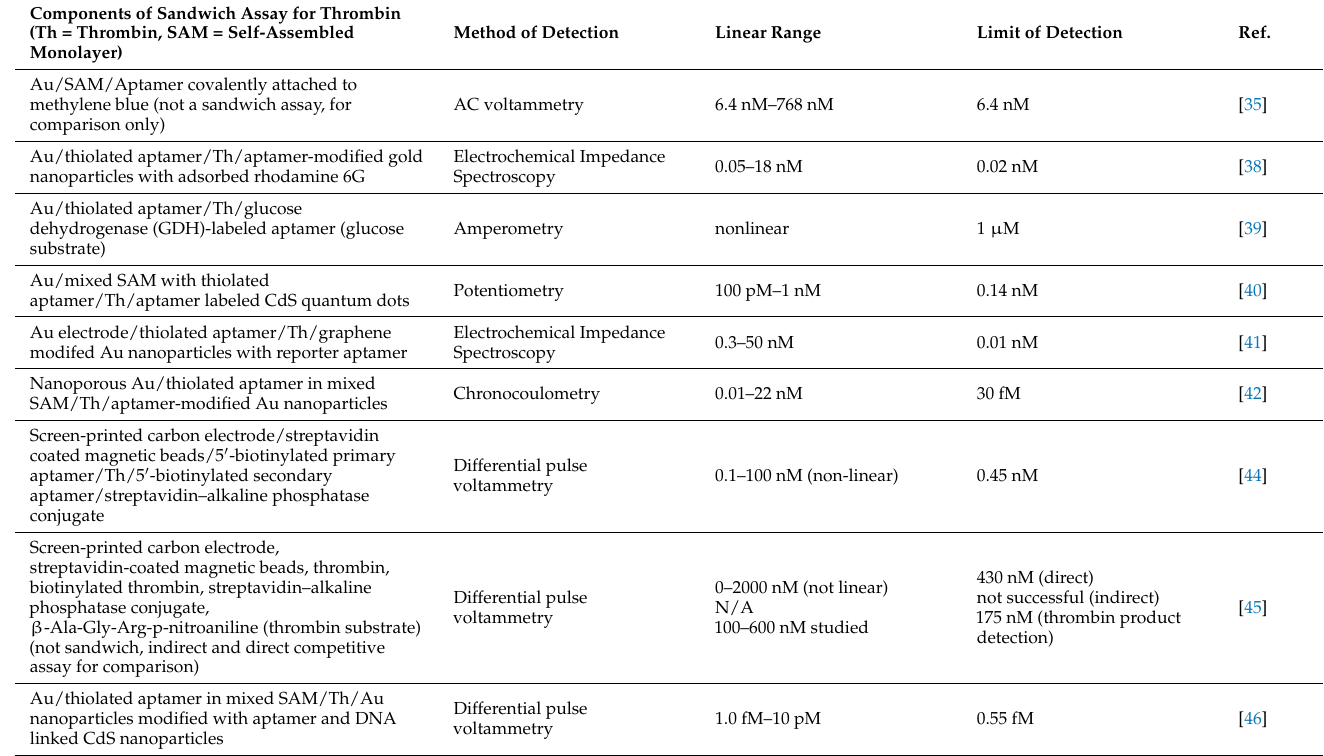
Table 1. Electrochemical Sandwich Assays for Thrombin using Aptamers.